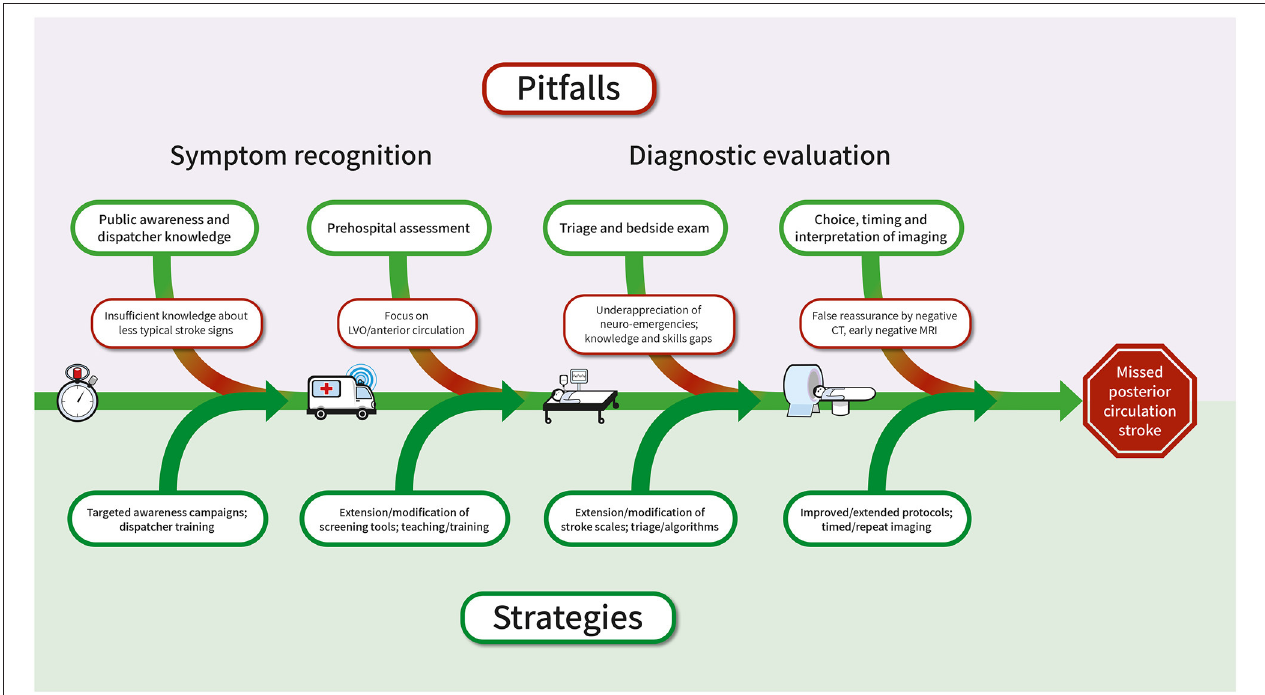
FIGURE 3 | Pitfalls associated with the diagnosis of PCS in the chain of acute stroke care and suggested approaches to solution. CT, computed tomography; MRI, magnetic resonance imaging; PCS, posterior circulation